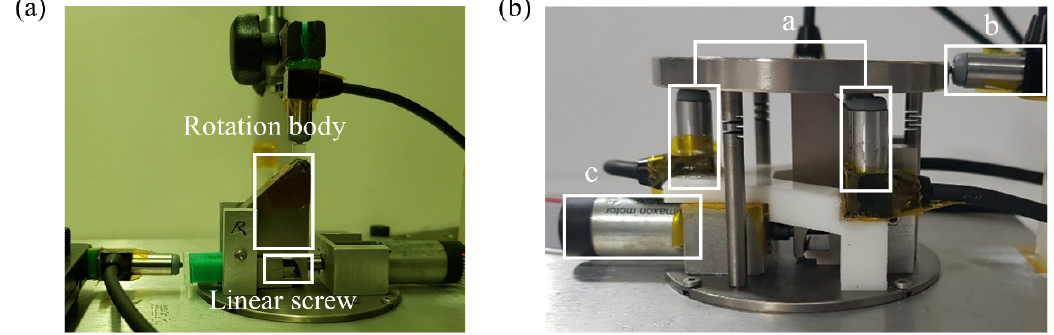
Figure 7. Photographs of the experimental setups; ( a ) Characterization of the rotation body, ( b ) Characterization of SMFH with five LVDT sensors for measuring a. vertical, b. horizontal displacements, and c. one-geared DC motor.